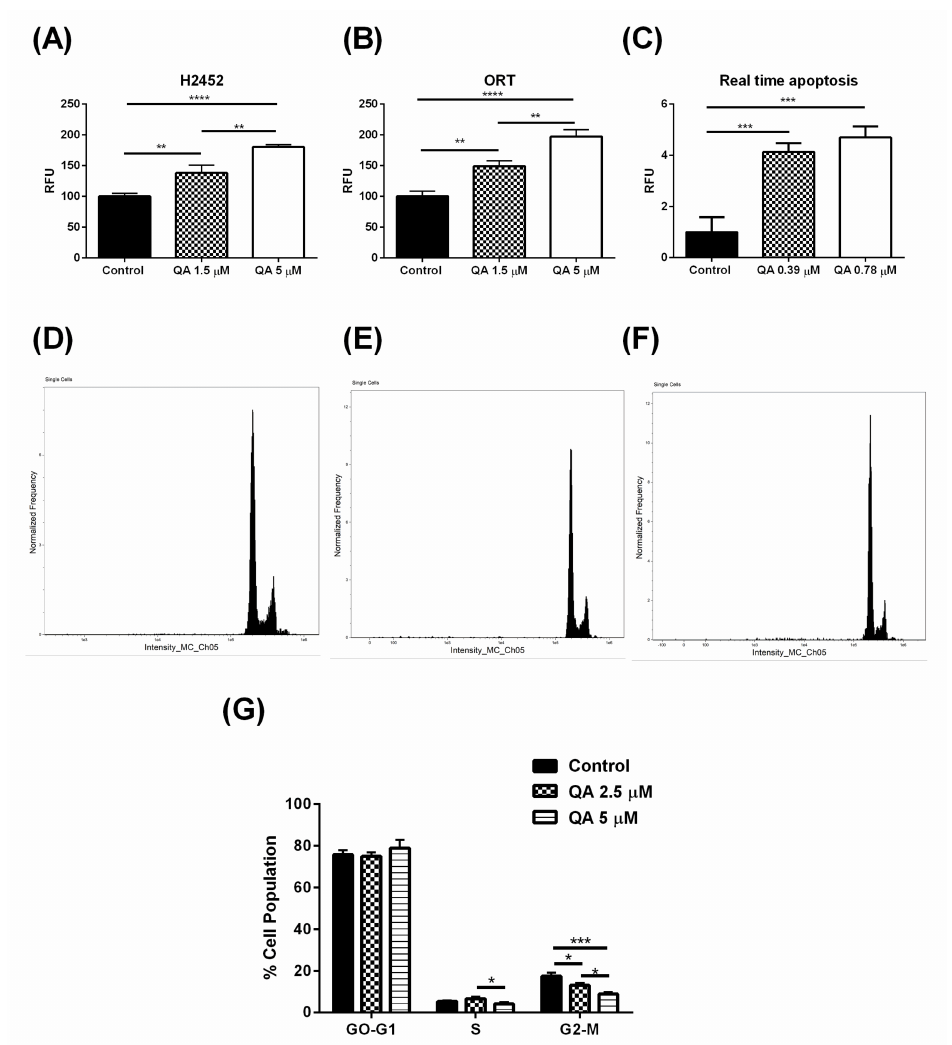
Figure 7. Representation of QA’s e ff ect on autophagy and apoptosis pathways along with its e ff ect on cell cycle in MPM cells. ( A ) Representation of autophagy inhibition performed by an autophagy assay kit in H2452 cells. It involves use of a probe that specifically binds to the surface LC3B protein present on an intermediate substrate in the autophagy process. Increase in fluorescence intensity represents higher degree of intermediate than the final product in autophagy process, indicating higher inhibition of autophagy H2452 cells. ( B ) Similar results were observed in patient-derived ORT cells where LC3B-2 expression levels were upregulated for QA-treated cells. ( C ) Plot represents in-vitro assay for determination of apoptosis in MM cells. Real time apoptosis study was performed for 3 h where an increase in levels of Annexin V were observed as QA concentration was increased (0.39- and 0.78 µ M). ( D – F ) Plots represent various phases of cell cycle for control cells and QA-treated cells, as analyzed using FlowSight flow cytometer. ( G ) Plot represents population of cells in various phases of cell cycle, obtained by measuring DNA content by PI staining using flow cytometer. A significant di ff erence can be seen in the population of cells in the G2-M phase as QA concentration is increased, indicating less population of cells are pushed towards mitosis and instead are arrested at the apoptotic stage. Data represents mean ± SD ( n = 3), * p < 0.05, ** p < 0.01, *** p < 0.001, **** p < 0.0001, compared between treatment and control groups, as